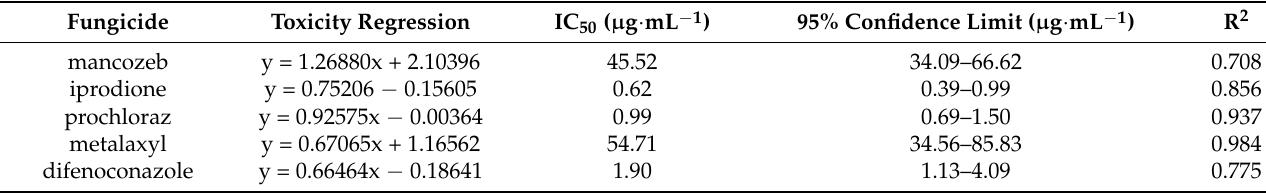
Table 2. Sensitivity of five fungicides against V.mali .